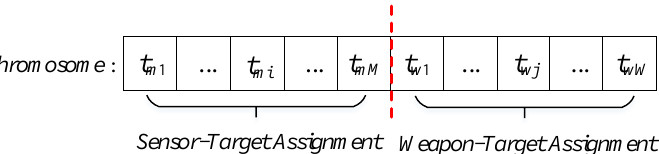
Figure 5. The illustration of the chromosome